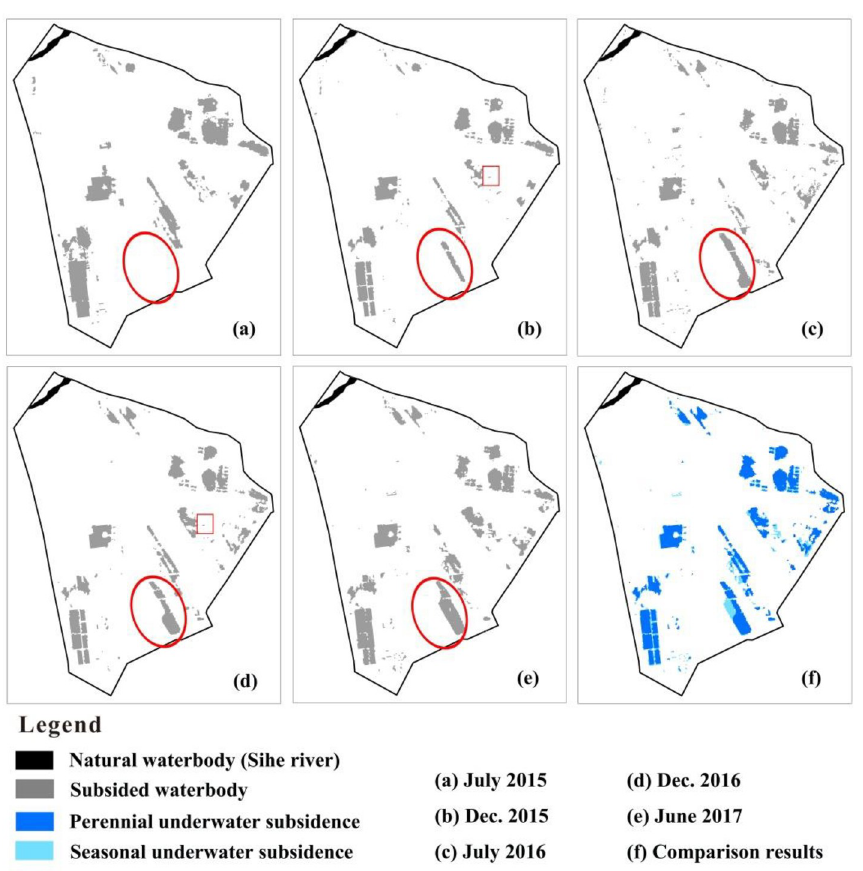
Fig 5. Underwater ground subsidence areas estimated from Landsat-8 OLI images. The image was obtained from the public domain, http://eros.usgs.gov, of the EROS Center. E-MNDWI values on (a) December July 2015, (b) December 2015, (c) July 2016, (d) December 2016, (e) June 2017, and (f) the comparison between perennial and seasonal underwater ground subsidence areas. The red eclipse and rectangle indicated the location of WP-A and WP-B,